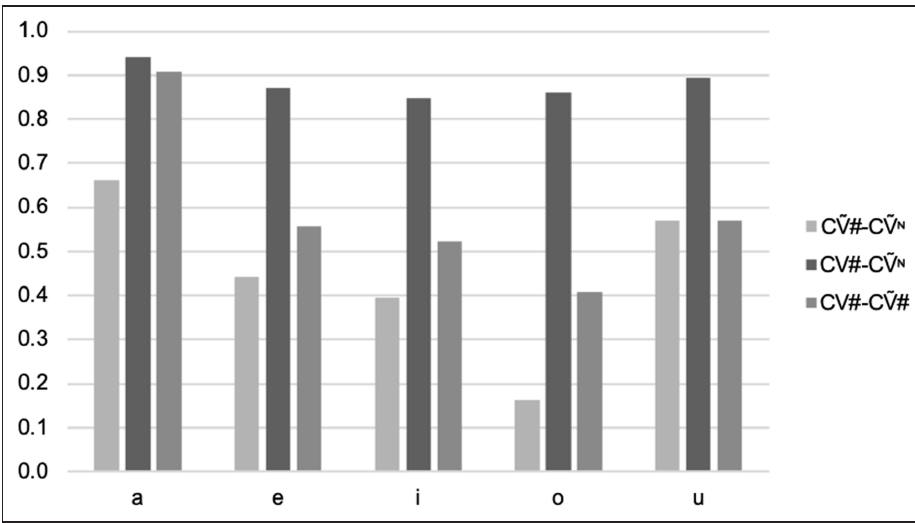
Figure 9: Overall accurate answers by vowel